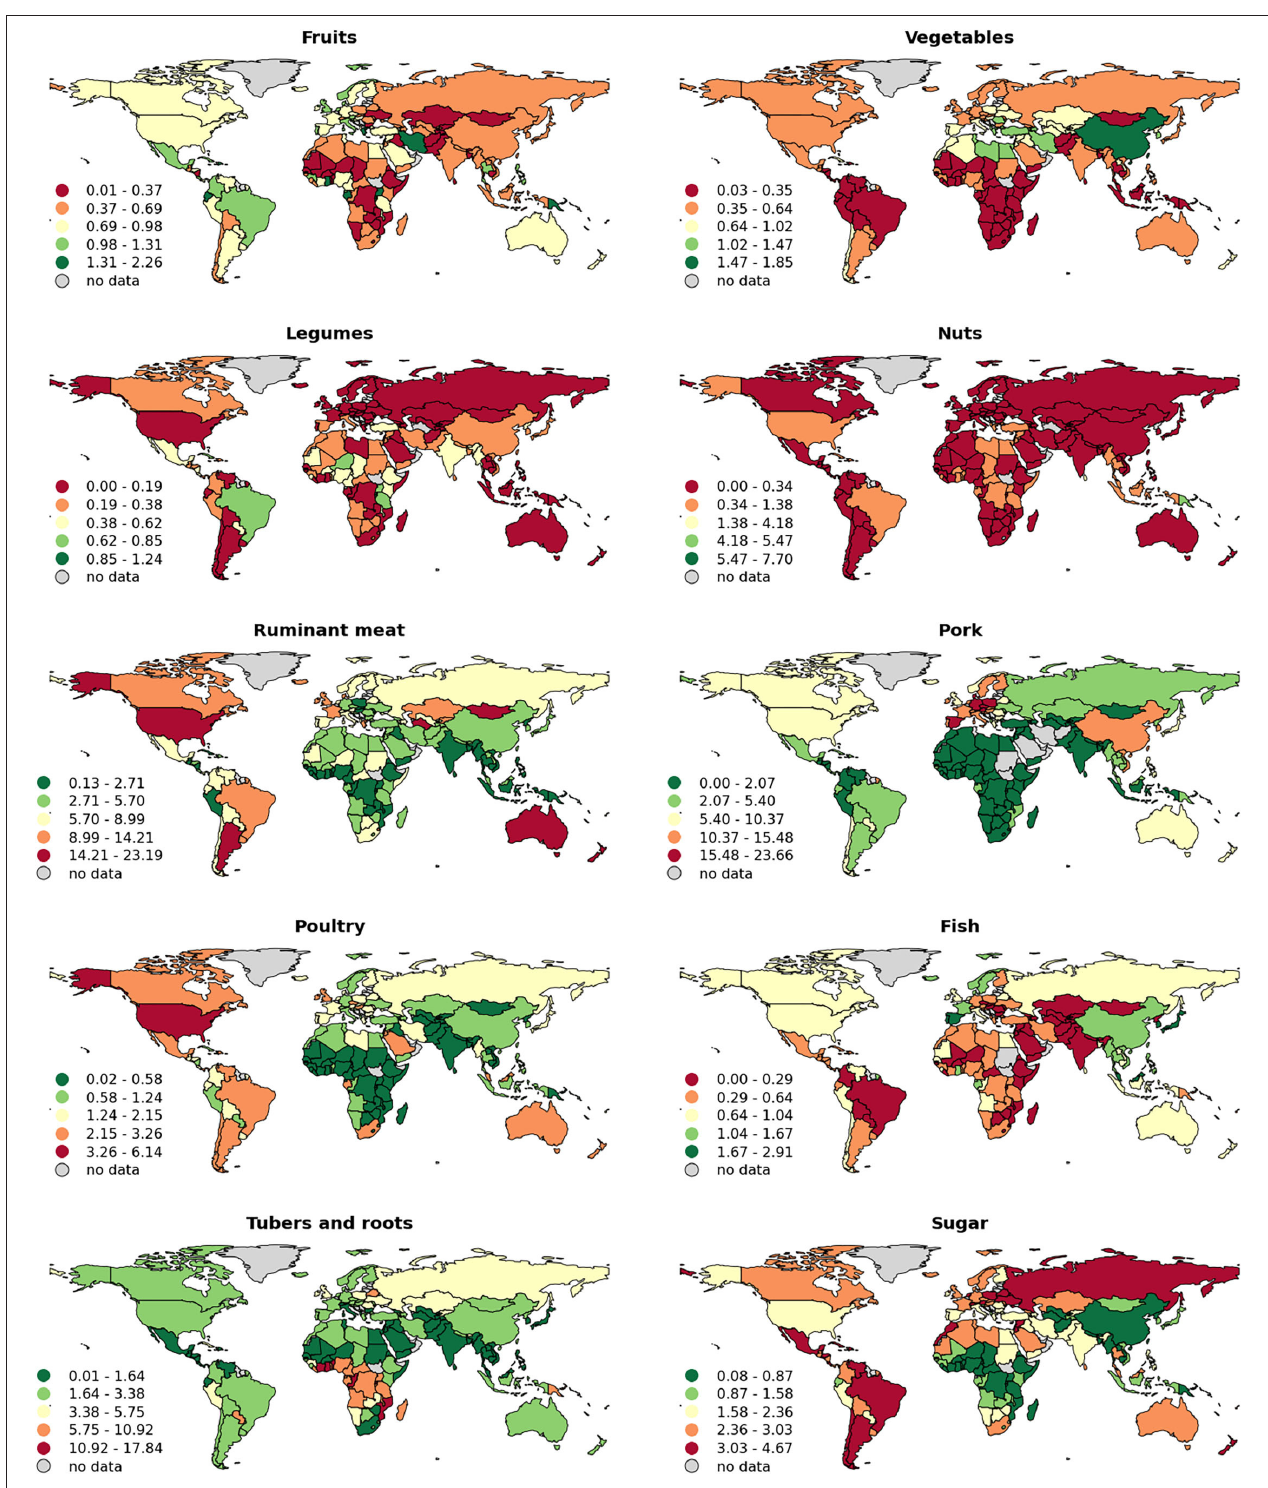
FIGURE 1 | Diets in different countries relative to the EAT-Lancet reference diet. Ratio of current to EAT-Lancet recommended intakes of different food groups per country are shown. We adopted the national average intake estimates (year 2010) from Willett et al. (2019), and the references proposed by EAT-Lancet Commission for the major food groups to calculate the ratios of current to reference intake levels. The darker red color indicates an insufficient intake of sustainable healthy foods or an excessive intake of unsustainable unhealthy foods in the national average diet.